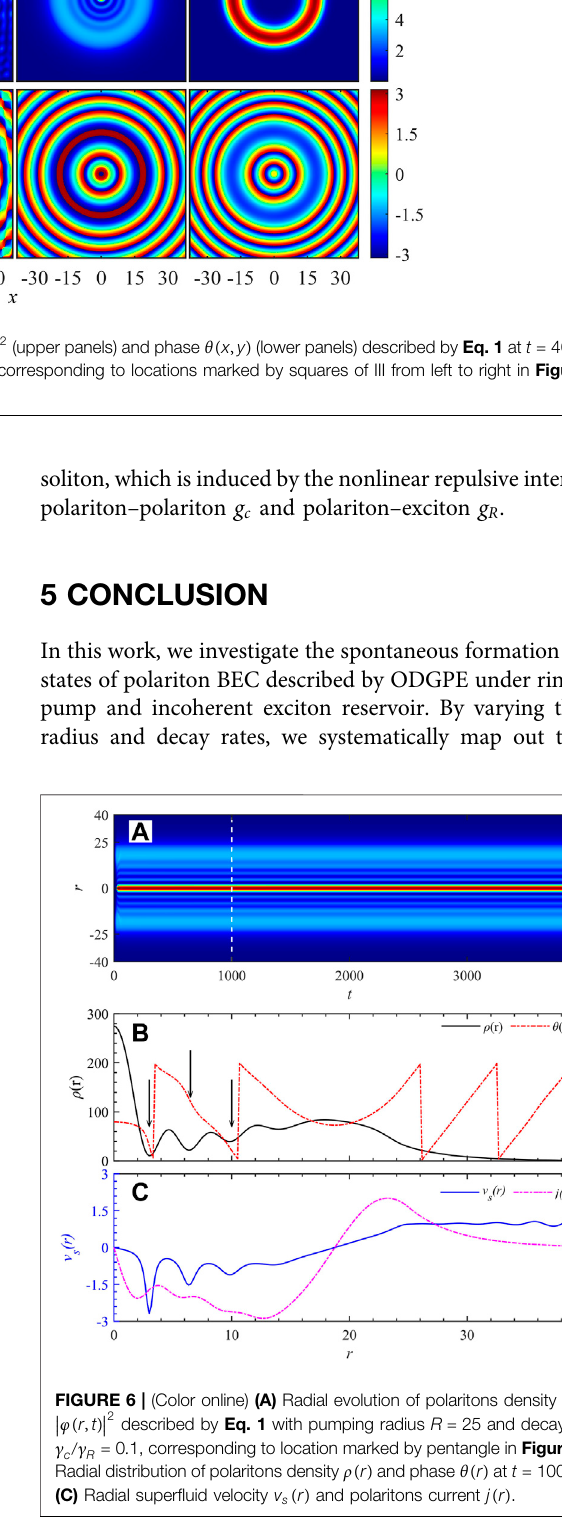
(cid:3)(cid:3)(cid:3)(cid:3) φ ( x , y )| 2 (upper panels) and phase θ ( x , y ) (lower panels) described by Eq. 1 at t (cid:2) 400